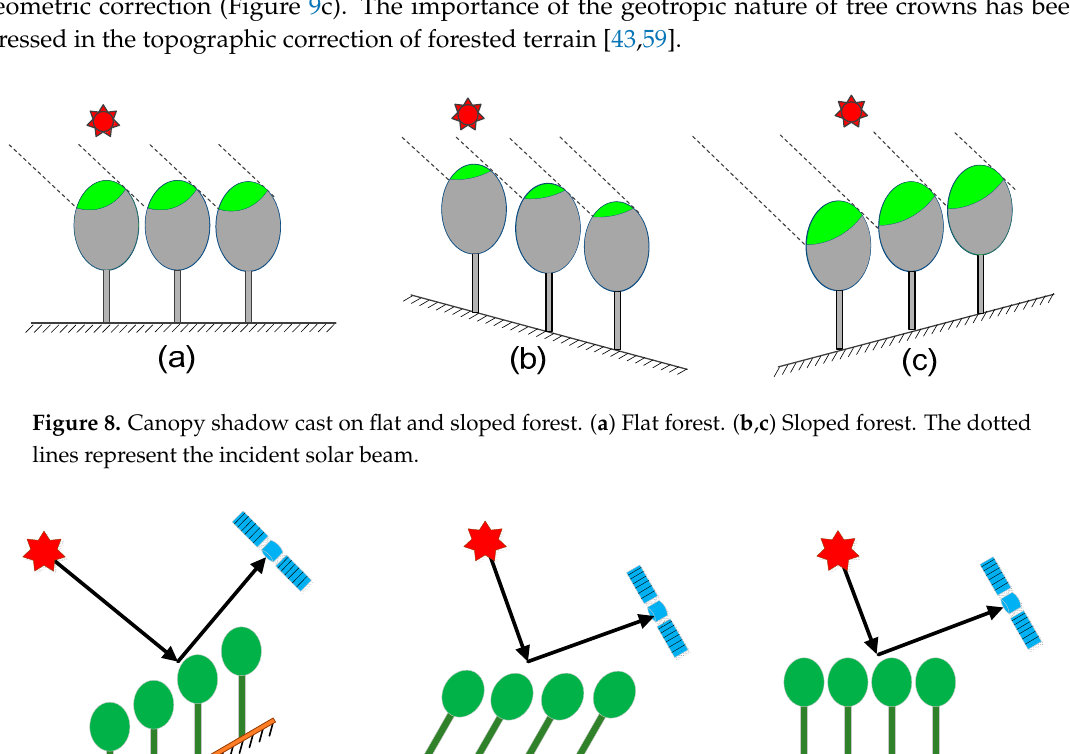
Figure 8. Canopy shadow cast on flat and sloped forest. ( a ) Flat forest. ( b , c ) Sloped forest. The dotted lines represent the incident solar beam.